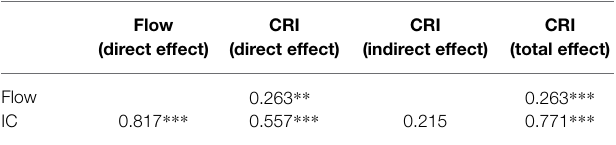
TABLE 4 | Direct, indirect, and total effects of each factor on creative role